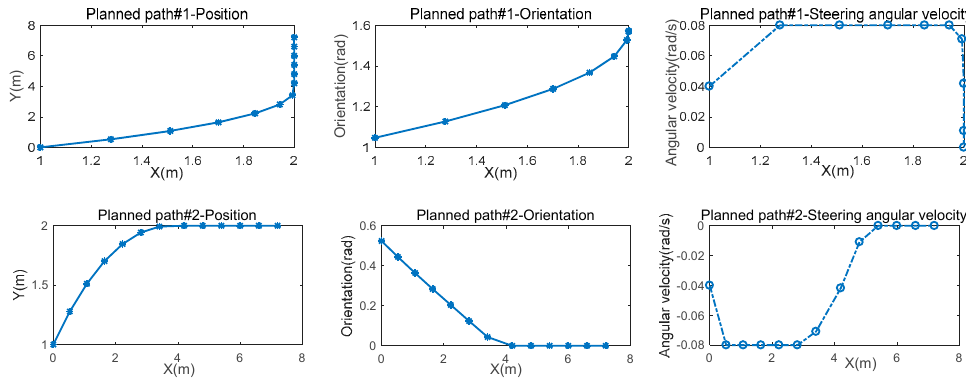
Figure 3. The pre-designed path #1 and path #2 for the path tracking control simulations. Table 1. The data used in simulations.